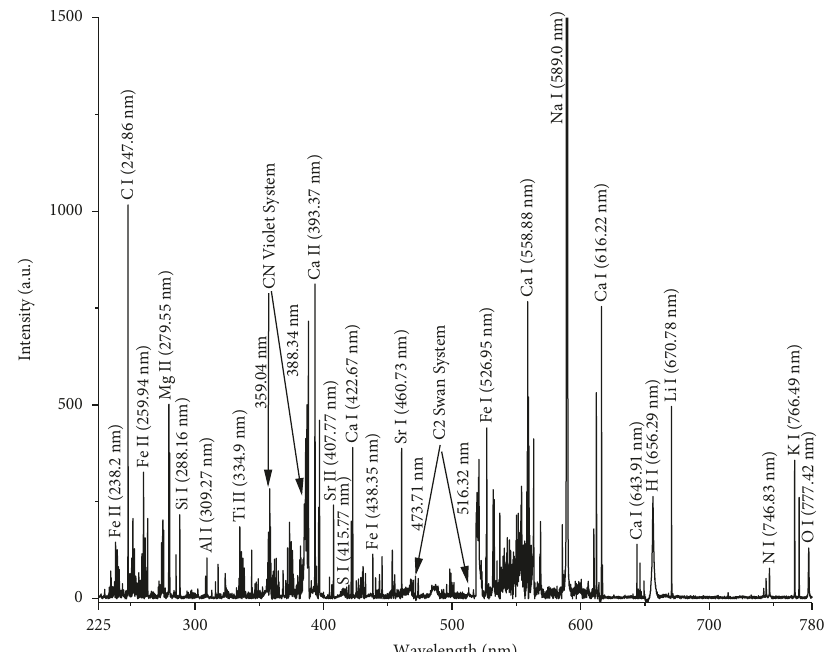
Figure 3: Portions of the emission spectrum from 225 to 780nm with major lines and CN and C